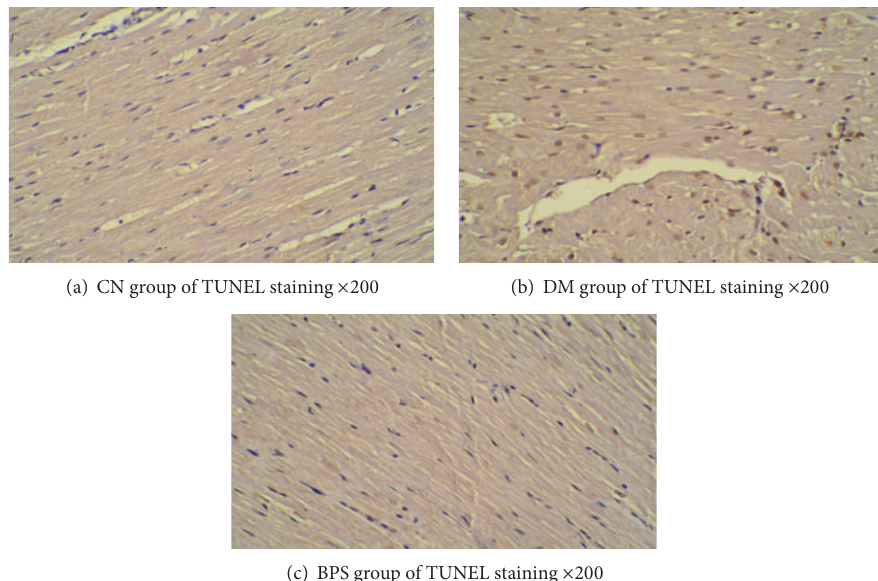
Figure 16: (a–c): Myocardial cell apoptosis results. Myocardial cell TUNEL staining is shown in (a)–(c). The CN group has the minimum number of positive staining cells (a). The DM group has the largest number of positive staining cells (b); compared with the DM group, the number of positive staining cells in the BPS group was significantly decreased